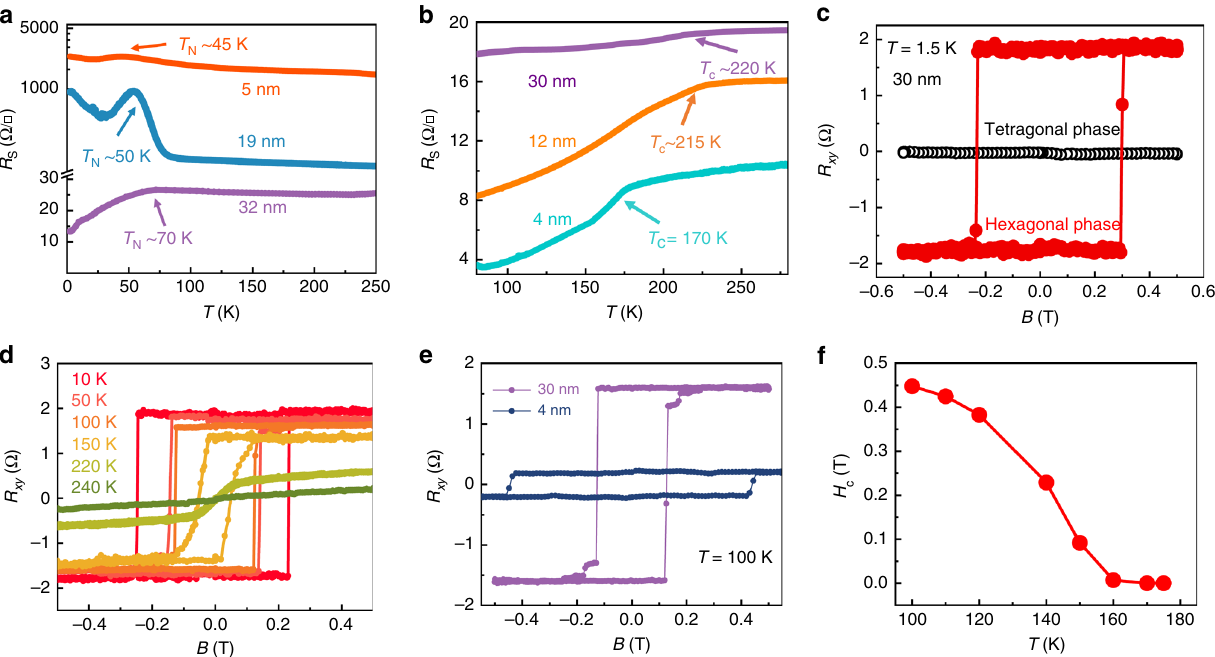
Fig. 4 Magnetic characterization of the FeTe nanosheets. a , b The temperature dependence of the longitudinal sheet resistance ( R S ) of tetragonal ( a ) and hexagonal ( b ) FeTe devices with different thicknesses, respectively. c The magnetic fi eld dependence of the Hall resistance ( R xy ) at 1.5 K corresponding to 32 nm tetragonal FeTe and 30 nm hexagonal FeTe. d Temperature-dependent anomalous Hall effect (AHE) of the hexagonal FeTe with 30 nm. e AHE hysteresis loops of hexagonal FeTe devices with 30 and 4 nm measured at 100 K. f The coercive fi eld of 4 nm hexagonal FeTe device as a function of the